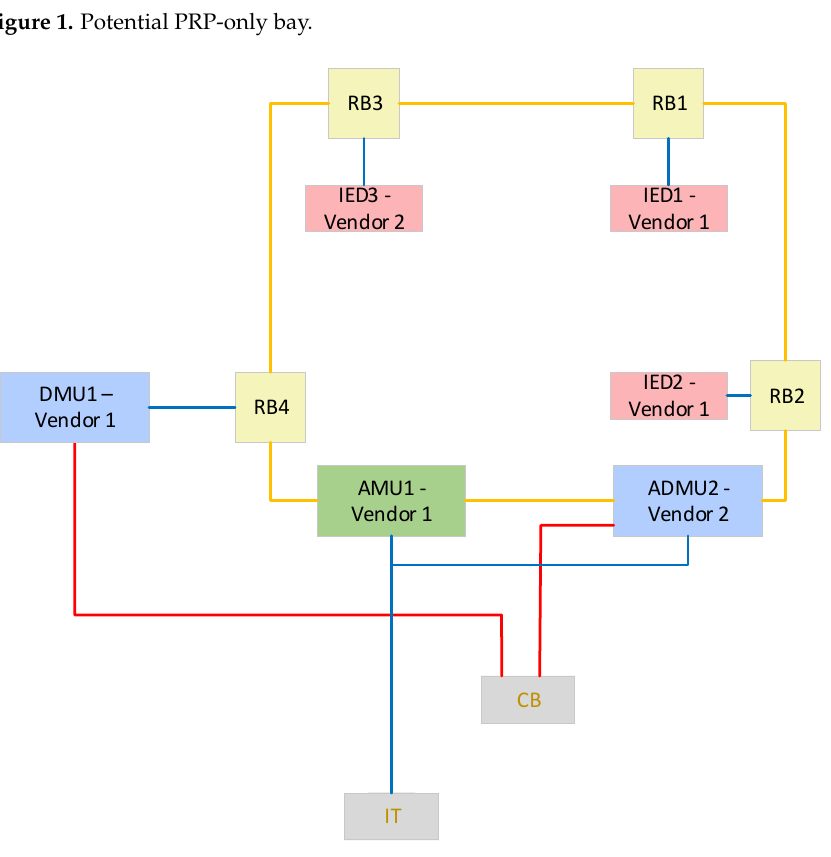
Figure 2. Potential HSR-only